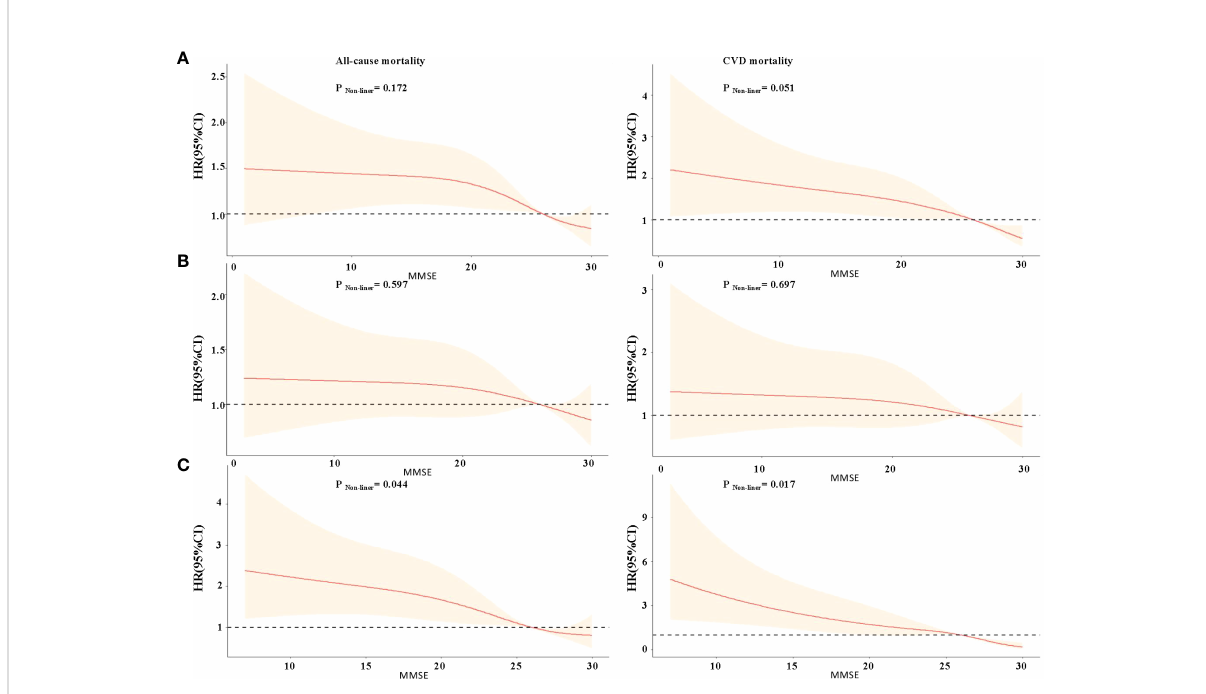
FIGURE 1 Restricted cubic splines for the association of MMSE score with all-cause and CVD mortality according to diabetes mellitus. (A) Total study participants; (B) non-diabetes mellitus group; (C) diabetes mellitus group. Hazard ratios (HRs) are indicated by red solid lines and 95% CIs by shaded areas. All models were adjusted for age, gender, residence, education, marriage, smoking status, alcohol drinking, exercise, BMI, WC, hypertension, dyslipidemia, coronary disease, COPD, tumor, TC, TG, and uric